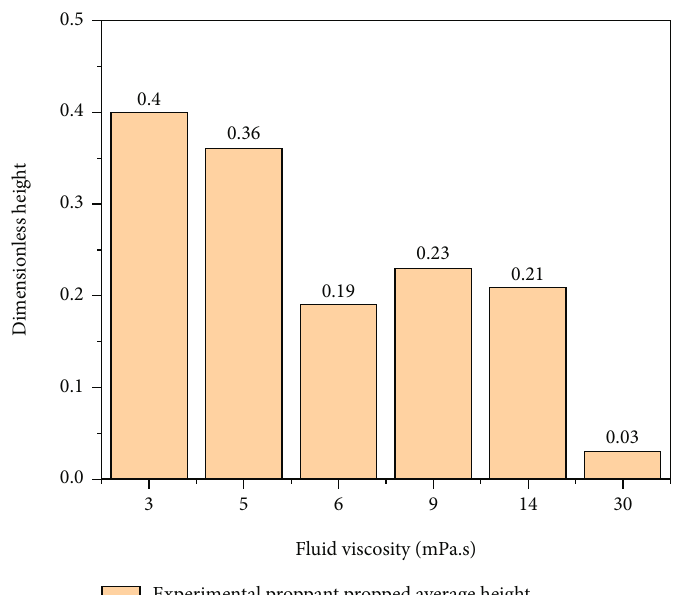
Figure 9: Comparison of 20/40 mesh quartz sand placement results with di ff erent fracturing fl uid viscosities.